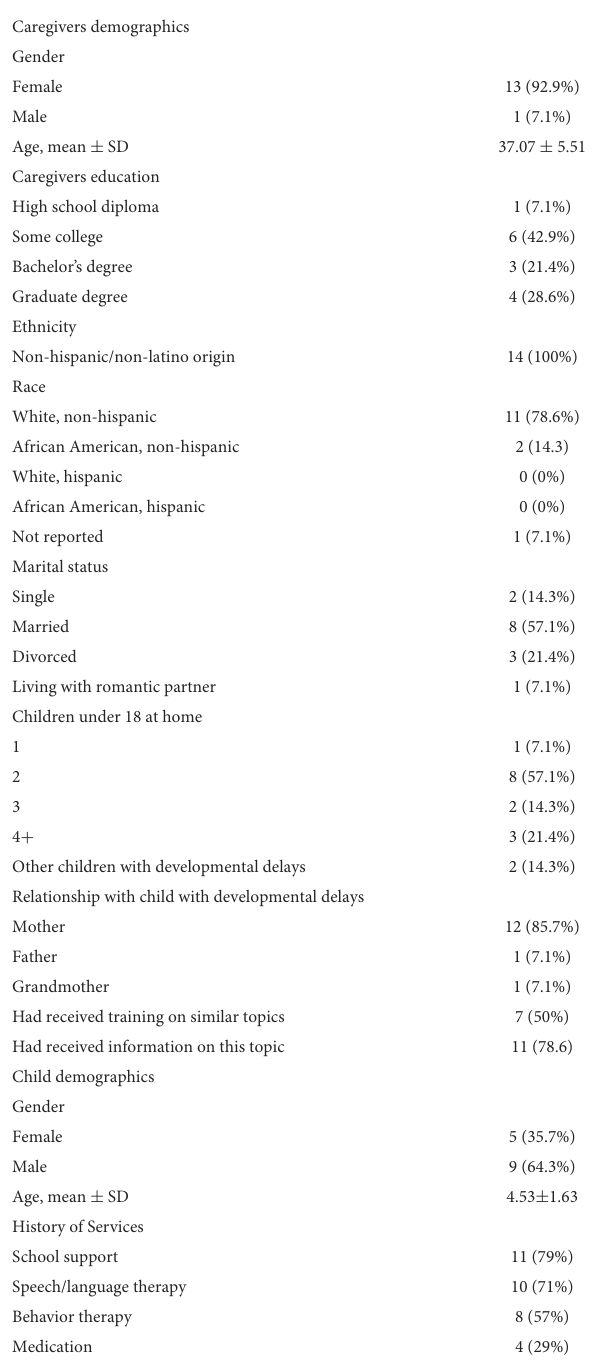
TABLE 1 Demographic characteristics of the